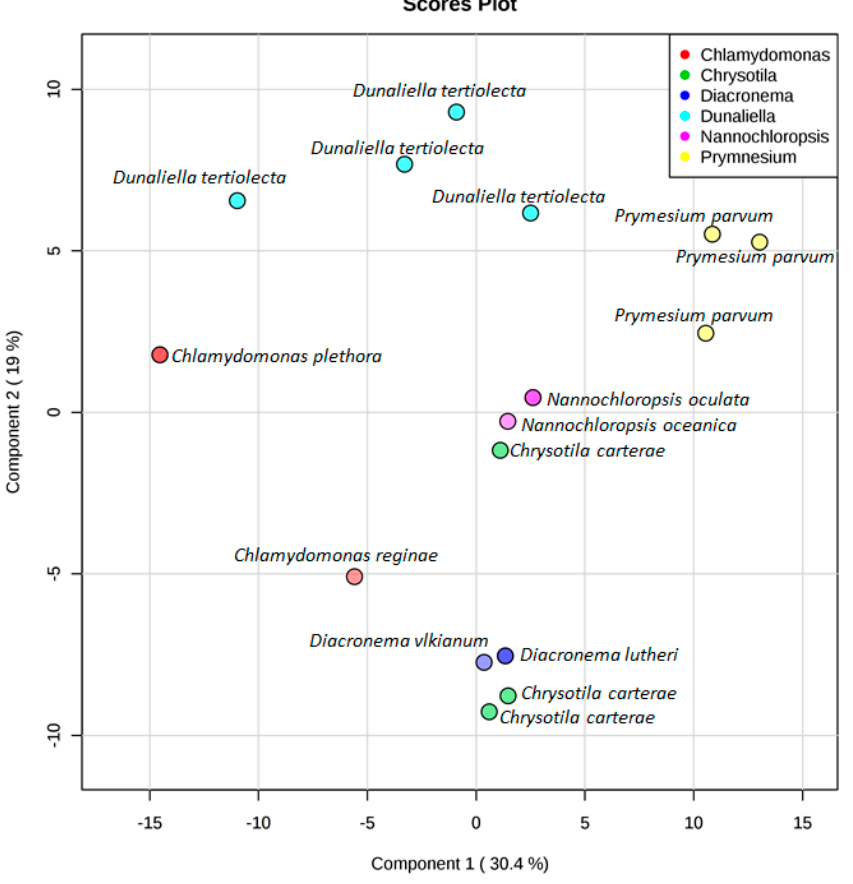
Figure 6. PLS-DA scores plot for Chlamydomonas spp. (red), Chrysotila carterae strains (green), Diacronema spp. (dark blue), Dunaliella tertiolecta strains (light blue), Nannochloropsis spp. (pink), and Prymnesium parvum strains (yellow) using component 1 (30.4%) and component 2 (19%) as axes.